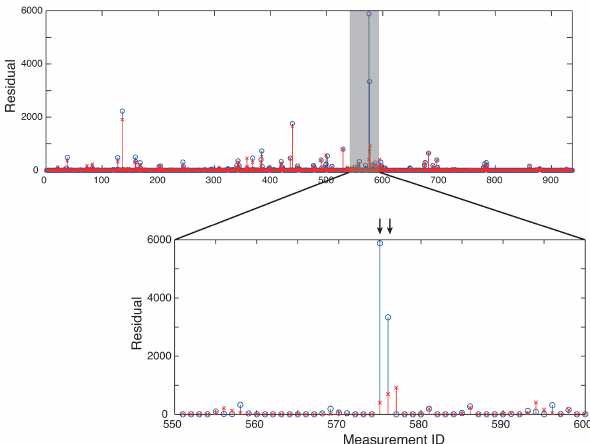
Figure 6. Residuals of two different source estimations: The blue peaks correspond to the residual produced by the solution ˆ x with the largest number of inliers in Fig. 4a. The black arrows on the top indicate where the two most critical measurements are localized. Clearly, the residual corresponding to these two measurements is much larger than the rest. The red peaks corresponds to the residual produced by the solution ˆ x with the smallest MSE in Fig.